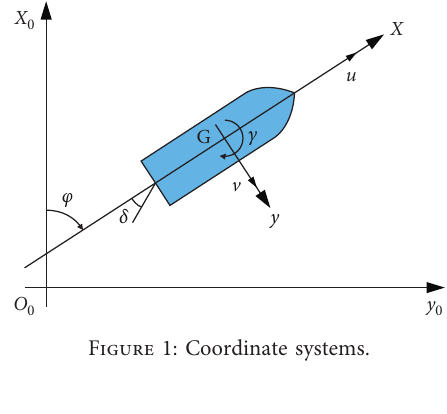
Figure 1: Coordinate systems.